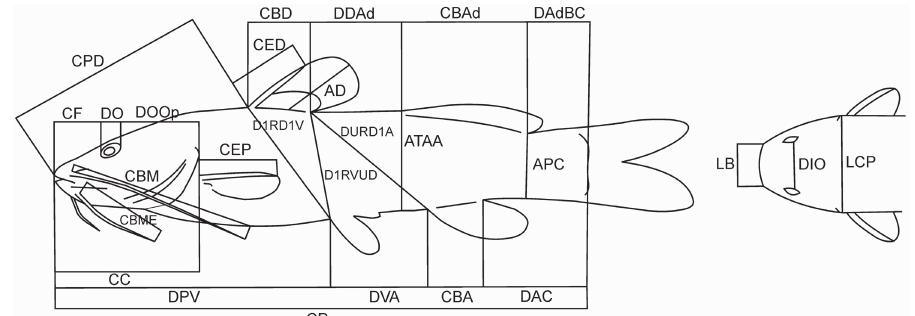
Fig. 1. Diagram of measurements taken from Rhamdia specimens for the principal component analysis . See Materials and Methods for explanation of